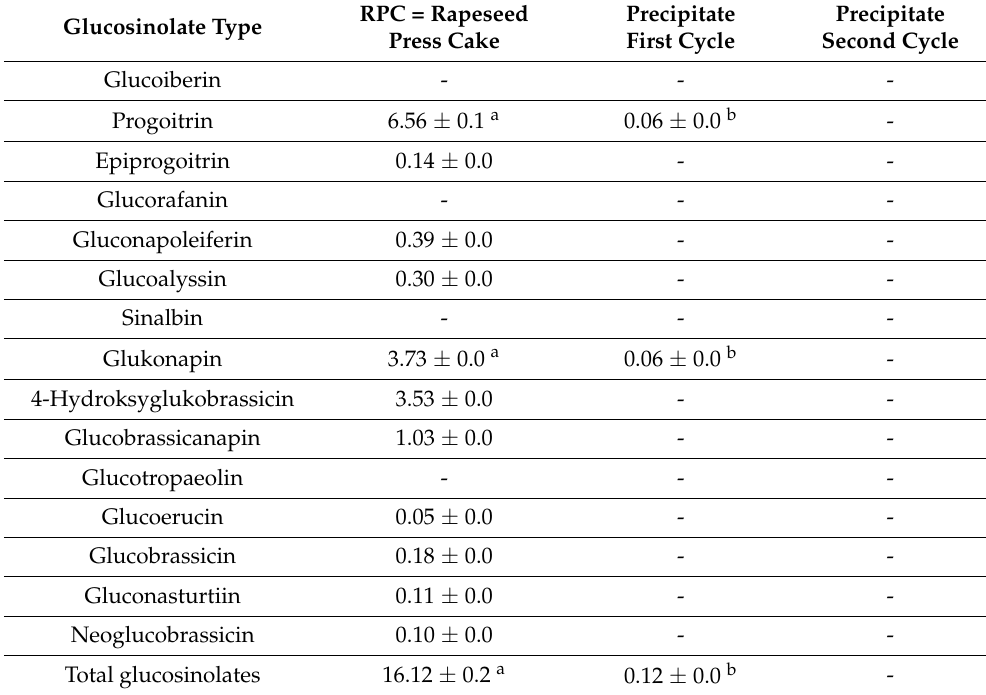
Table 4. The concentration of the glucosinolates in the rapeseed press cake and the precipitate from the first and second cycle. The concentration is expressed as µ mol/g on dry basis and different letters indicate significant differences. Dash (-) indicates that the glucosinolate concentration was below the detection